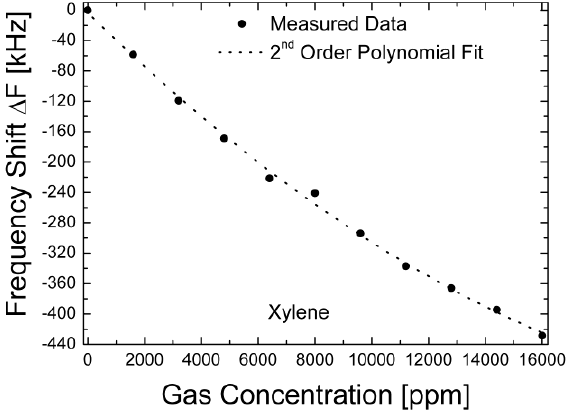
Figure 11. Sensitivity vs. xylene for the FPAR with 380 nm